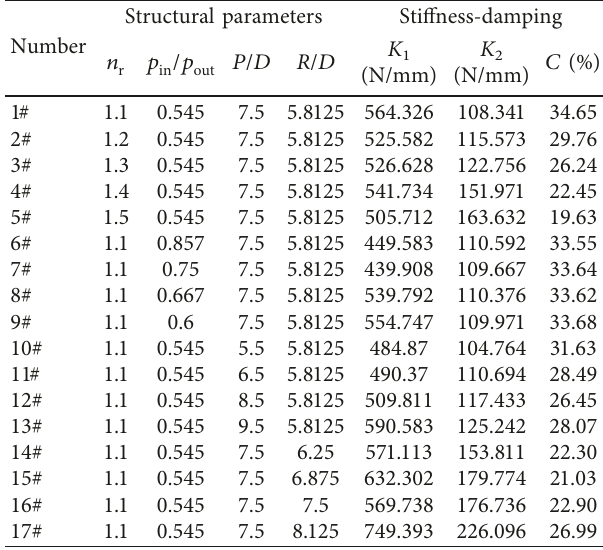
Table 6: The stiffness-damping of the GGQ-99 WRI with different structural parameters.